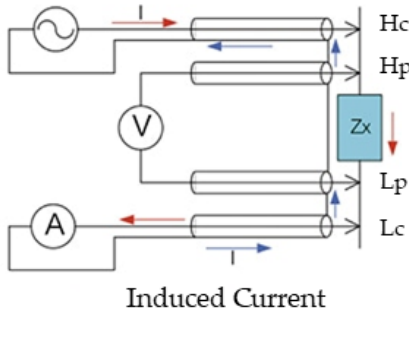
Figure 9. The LCR meter measurement circuit—Four Terminal Pair Method.